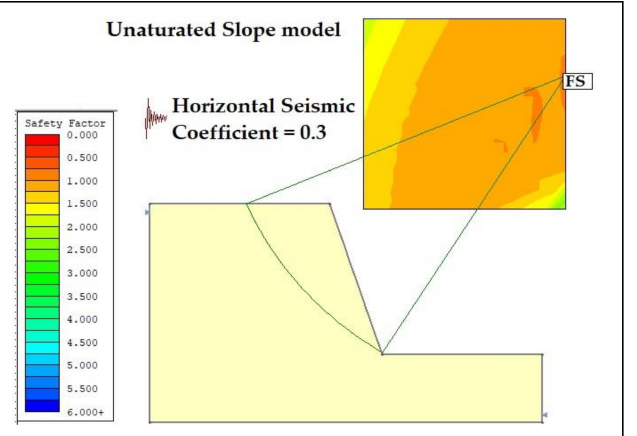
Figure 9. Slope model—unsaturated seismic case.